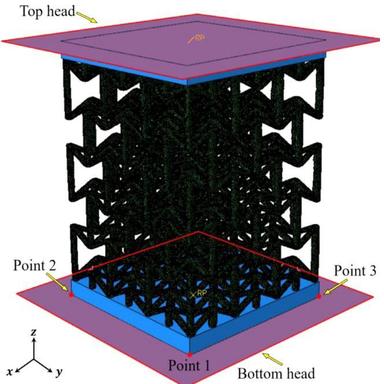
Load-displacement curves obtained by FE simulations of the CAD model and CT reconstructed model and compression test.